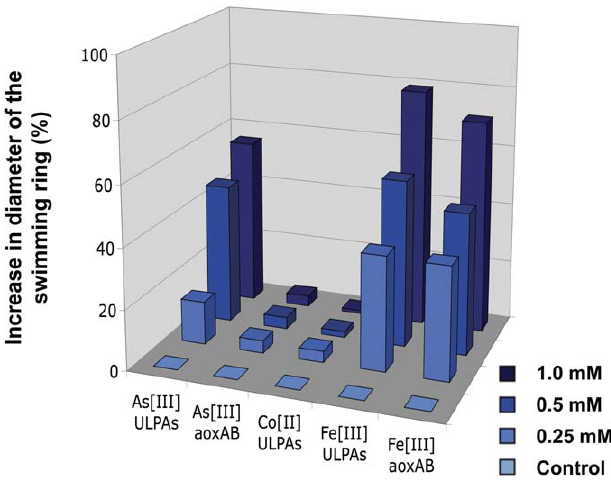
Figure 6. Effect of Metal and Metalloid Concentration on Swimming Properties in H. arsenicoxydans Motility assays were performed in the presence of an increasing concentration of As[III], Co[II], or Fe[III]. The level of motility of ULPAs wild-type strain and of its aoxAB knockout derivative was evaluated as the diameter of the swimming ring expressed in millimeters. The results are the mean value of three independent experiments.